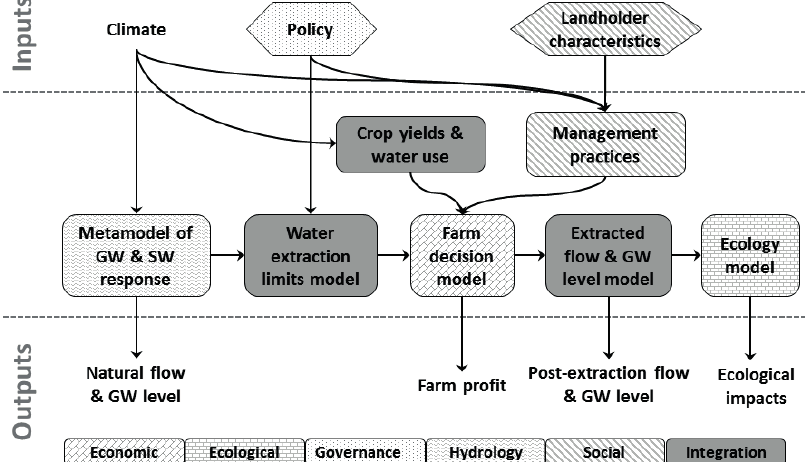
Fig. 1 Schematic overview of the Namoi integrated model (GW: groundwater, SW: surface